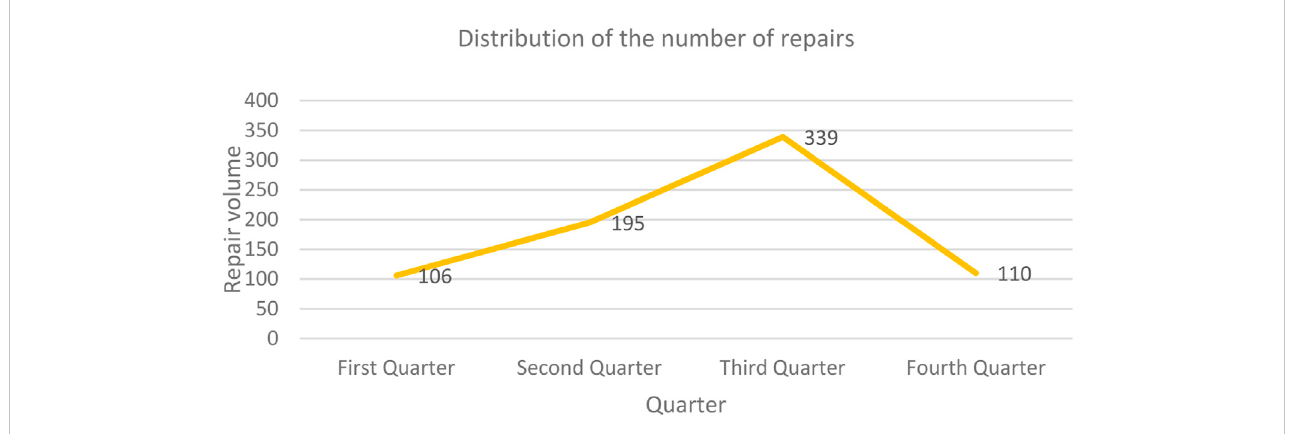
FIGURE 5 Distribution of monitor repair volume in four-quarters.